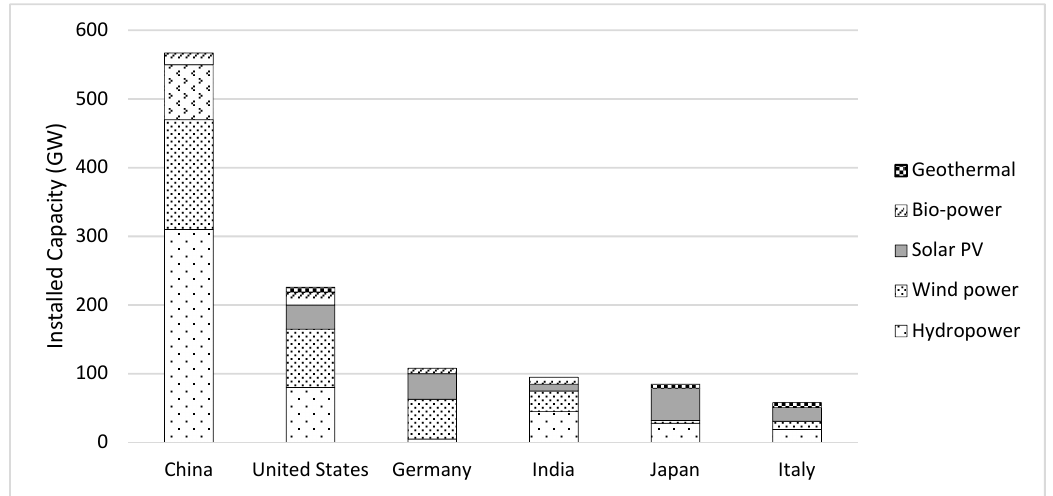
Figure 8. China has the world’s largest total hydropower capacity.